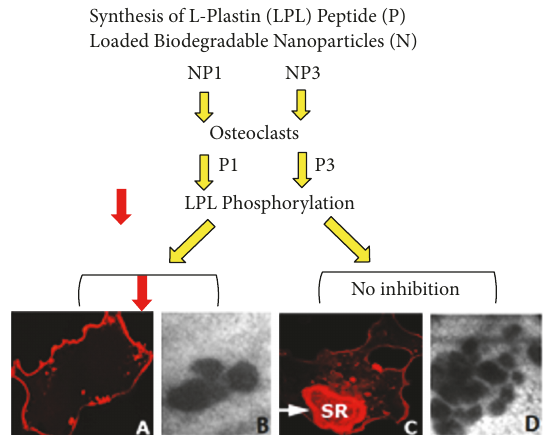
Figure 8: Schematic representation of the effects of small MW L- plastin (LPL) peptides on osteoclast bone resorption . Biodegradable and biocompatible PLGA-PEG nanocarriers were used to deliver and release the small molecular weight L-plastin peptides (NP1 or NP3) of interest in a controlled and sustained fashion. Osteoclasts were incubated with these nanoparticles of interest in the presence of TNF- 𝛼 . The released peptide P1 attenuated TNF- 𝛼 induced phosphorylation of cellular LPL. Therefore, the formation of NSZs and sealing rings as well as resorption activity are significantly reduced (red arrows) in osteoclastsin vitro. No inhibition was found with the control peptide (P3). Sealing ring (SR) is indicated with an arrow in